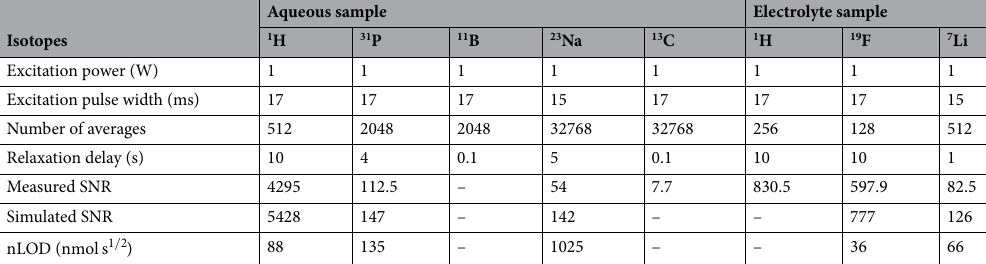
Figure S2a–e compare the digital twins of the NMR spectra, constructed from the simulation results, with the actual spectra collected from different nuclei. For an easier comparison, the simulation results were adjusted to include all experimental parameters, e.g., number of averages and bandwidth. The results have also been scaled to have the same noise level. Two major differences between the simulation and measurement results can be observed: (1) the broader and distorted simulated spectra report on severe static field distortion as discussed in Fig. S1d. In the measurement results, the shim adjustment was employed to compensate for these distortions and, as a result, the spectral resolution has been improved. (2) The measurement results exhibit lower SNR with respect to the simulation. This is because of the noise contribution and power loss imposed by the elements in the signal flow chain. The SNR resulted from both simulated and measured spectra are listed in Table 2. The difference between the simulation and measurements is more prominent for low gyromagnetic-ratio nuclei because of their lower intrinsic SNR. Figure S2f compares the 1 H nutation signals calculated from measure- ments and simulations. The decay rate of the nutation signal matches perfectly with the simulation results. The 17 µ s in the experimental and 13 µ s in the only difference between these results is the π/ 2 pulse lengths ( τ π/ 2 =